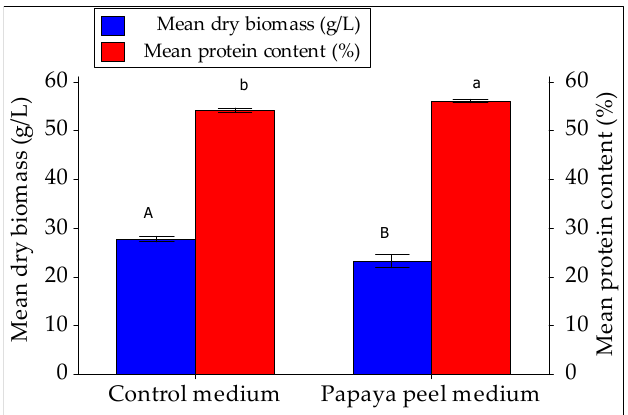
Figure 5. Dry weight and protein content of biomass produced in papaya peel medium and control medium under optimization. Comparisons of mean were performed with Tukey’s multiple comparison test at p < 0.05. Different uppercase and lowercase letters indicate the significant differences in dry biomass and protein content, respectively. A,B: Dry biomass; a,b: Protein content.